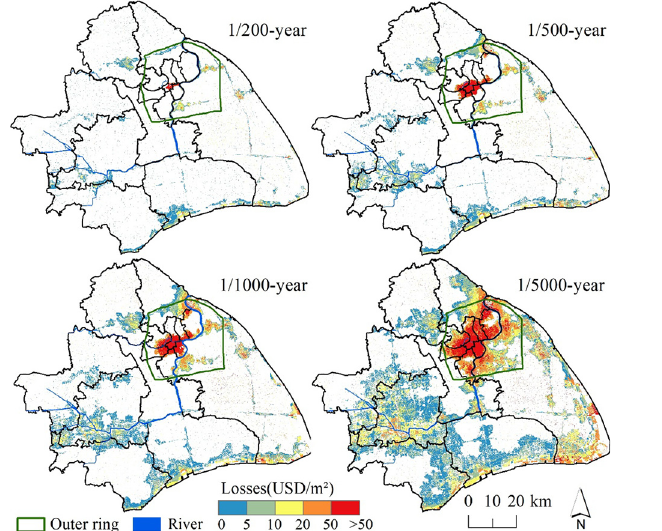
Figure 4. Spatial distribution of